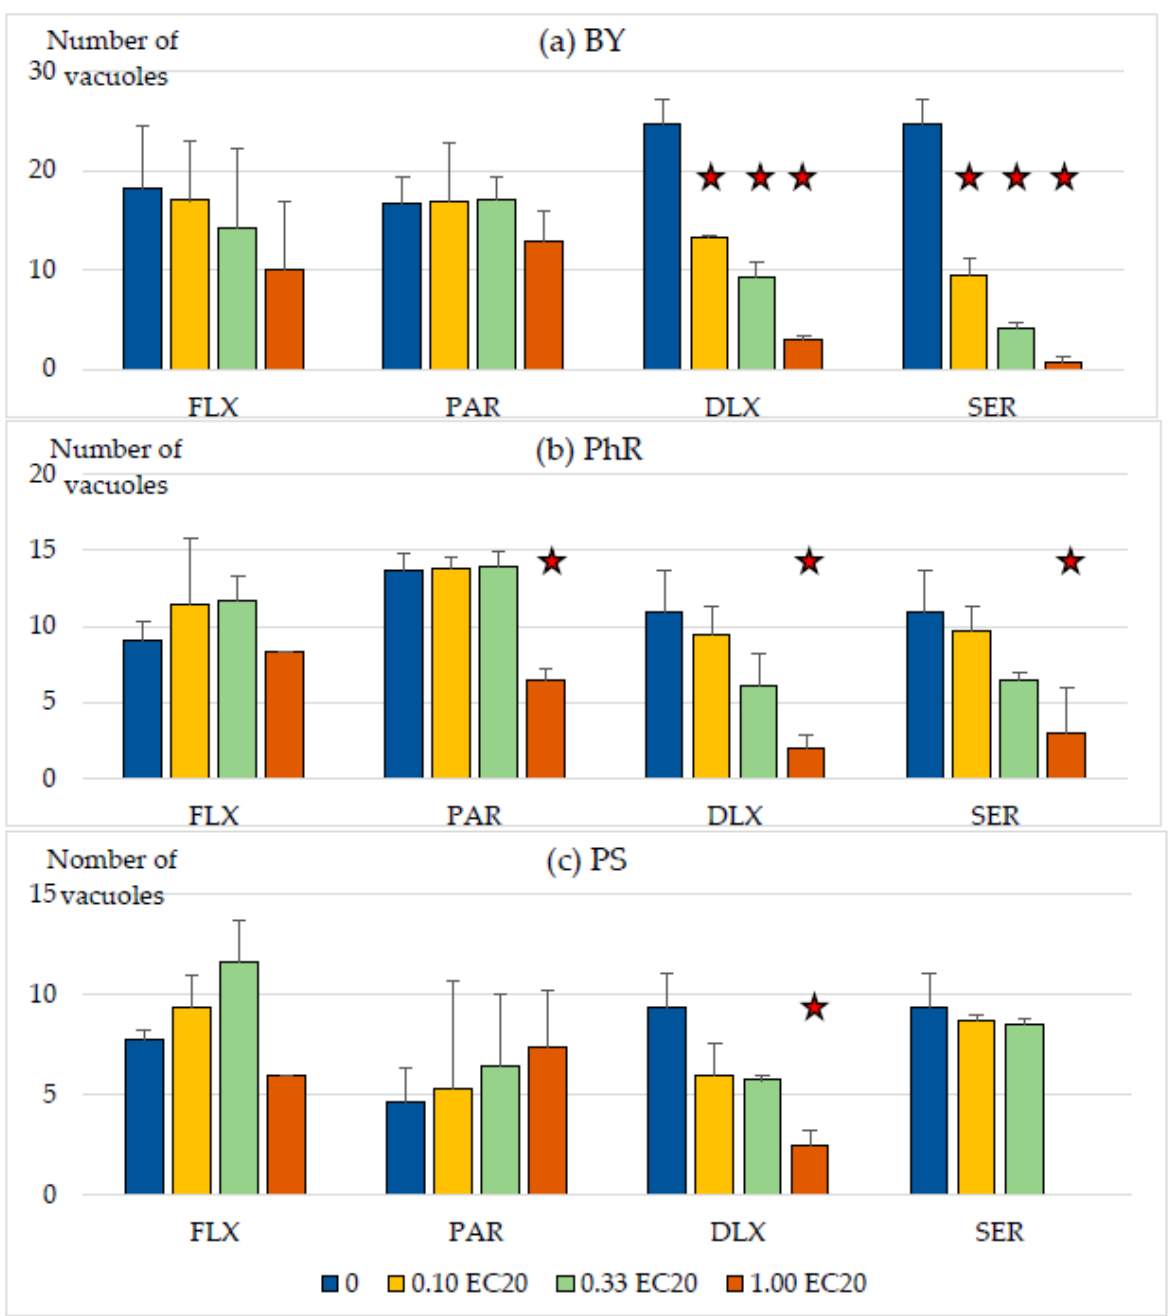
Figure 5. The number of food vacuoles formed by S. ambiguum incubated in the tested antidepressant solutions after administration: ( a ) baker’s yeast; ( b ) phenolic resin microparticles; and ( c ) polystyrene microparticles. Asterisk indicates the statistical difference in comparison with the control (sample without pharmaceutical)— p < 0.05.